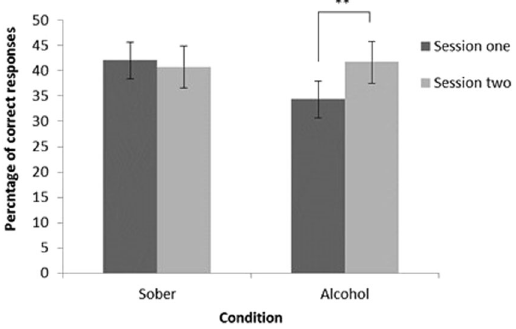
Figure 4. The proportion of correct responses during the cued recall task between the alcohol and sober conditions during session one and two. A significant increase in correct responses between sessions was found in the alcohol condition only ( p = 0.008). There were no significant group